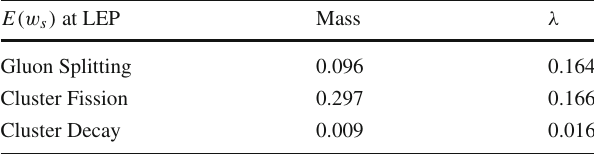
Table 5 Expected value of strangeness production weight of our new model in LEP events at 91.2 GeV, comparing the total invariant mass results with the λ measure results